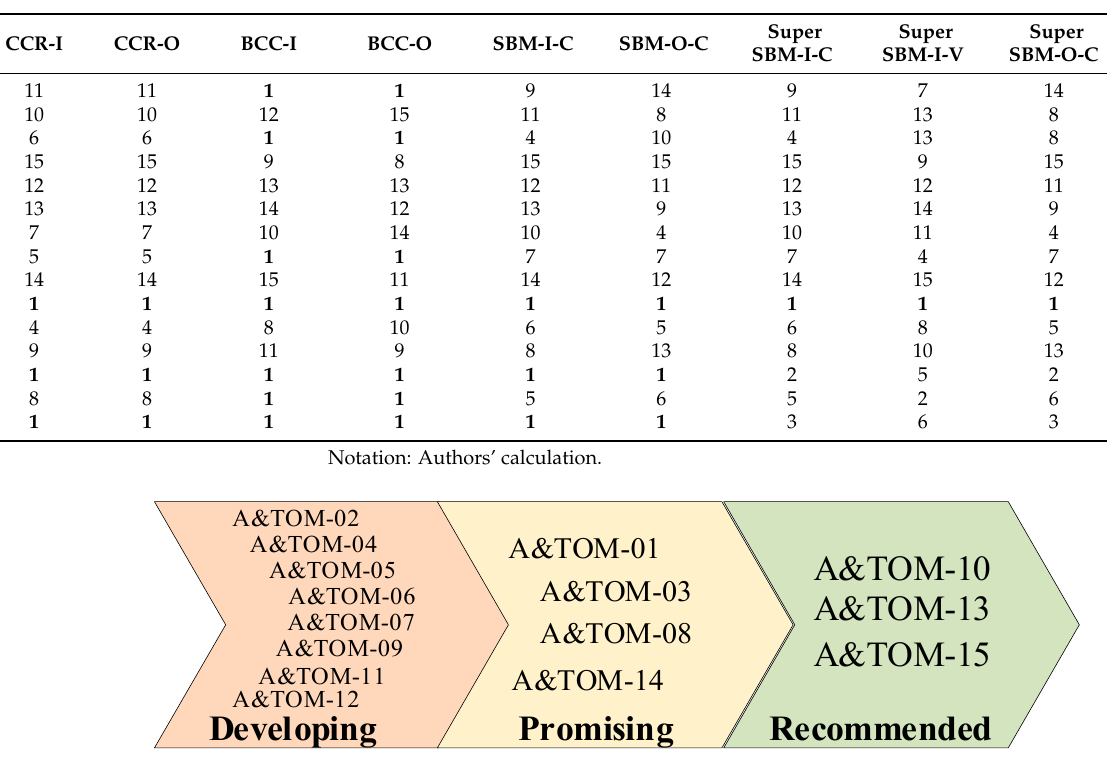
Table 18. A&TOMs ranks with nine DEA models.